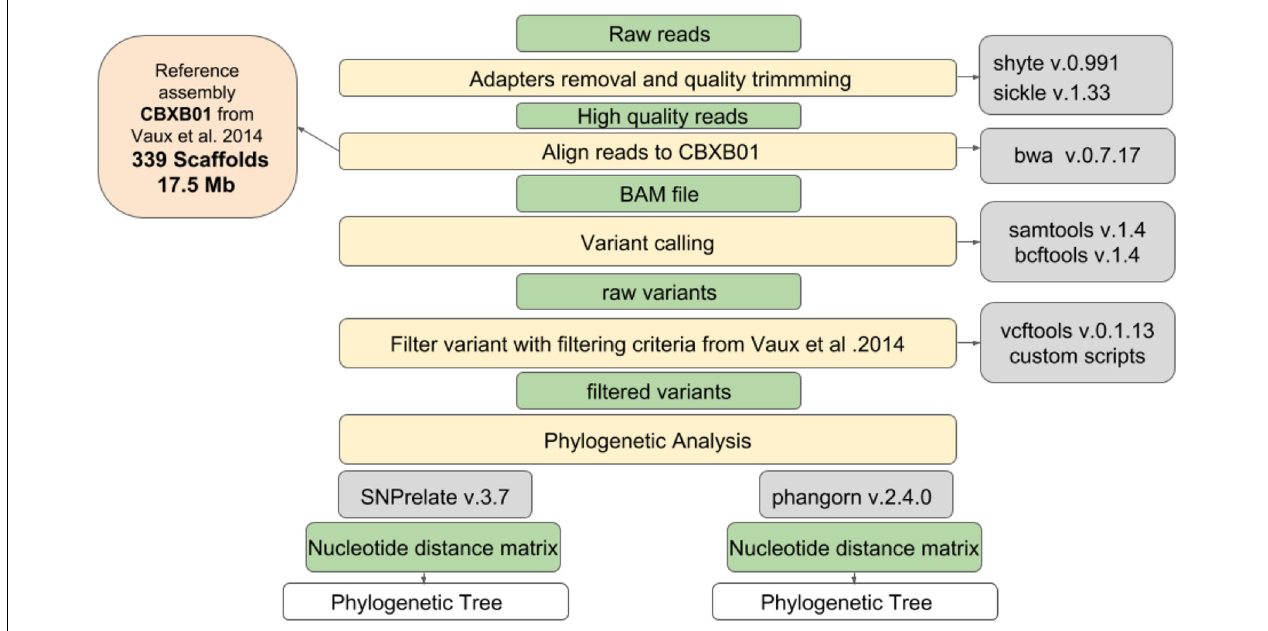
FIGURE 1 | Workflow used to produce the phylogenetic tree of isolated Saprochaete .